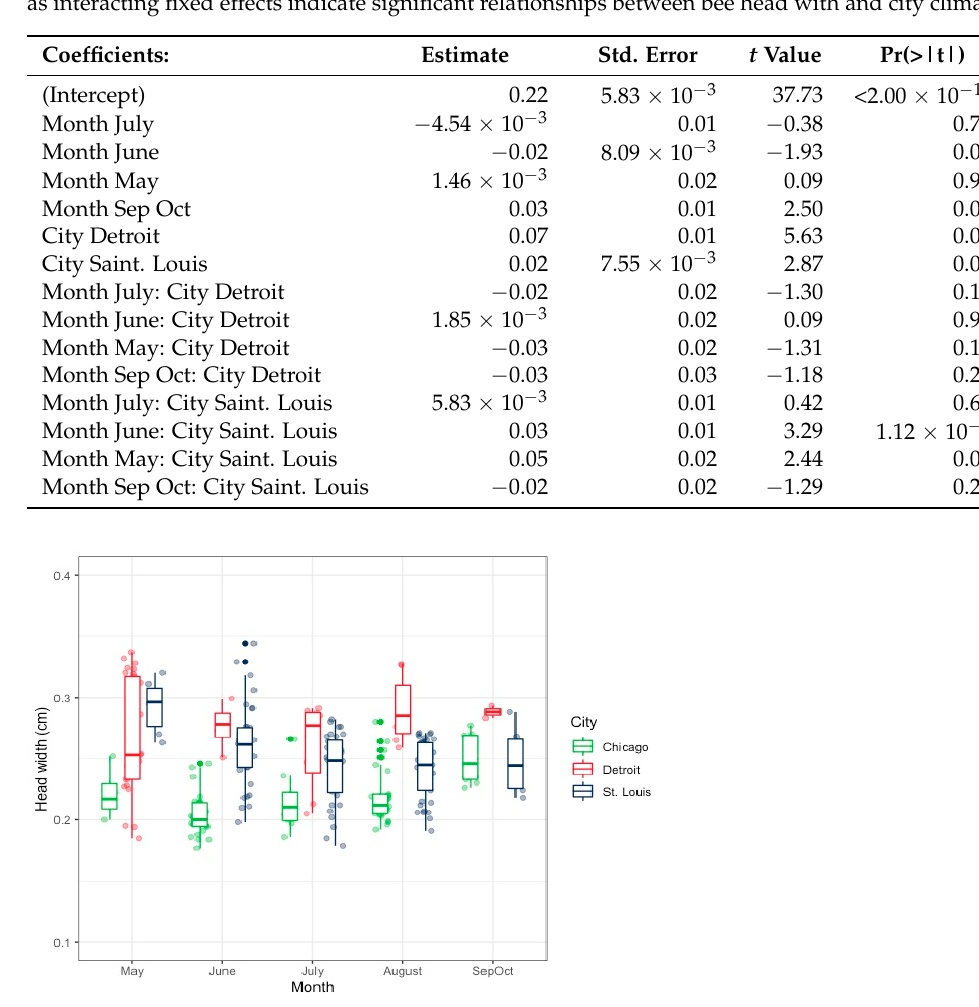
Figure 5. Variation in body size of female Halictus ligatus sweat bees throughout the season in Chi- cago, Detroit, and Saint Louis.